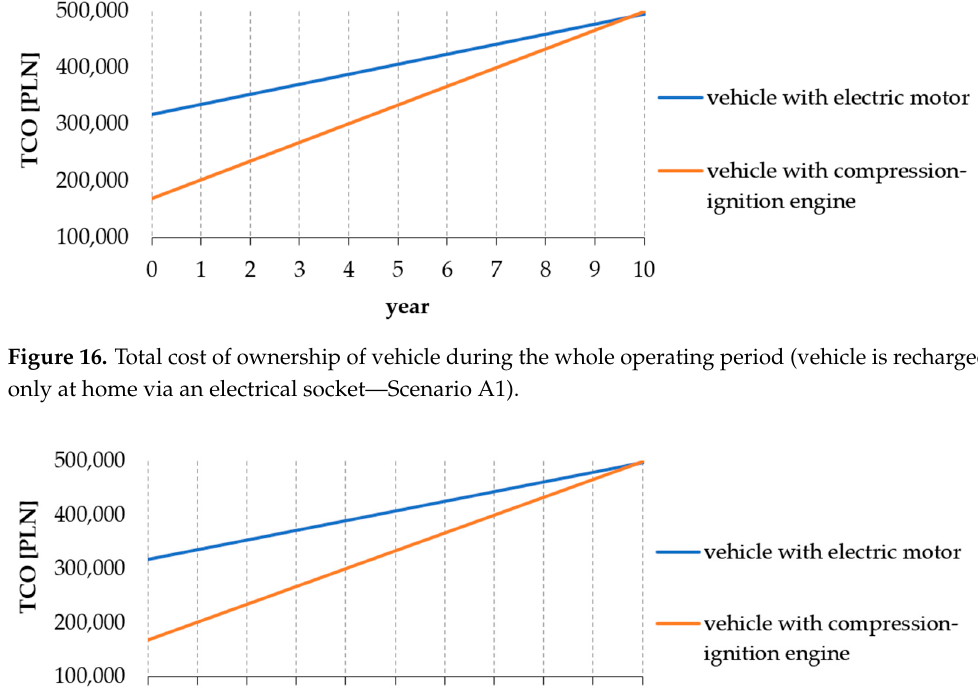
Figure 18. Total cost of ownership of vehicle during the whole operating period—electric vehicle is recharged only at public AC charging stations (the highest price for 1 kWh was included in the calculations—Scenario A3).